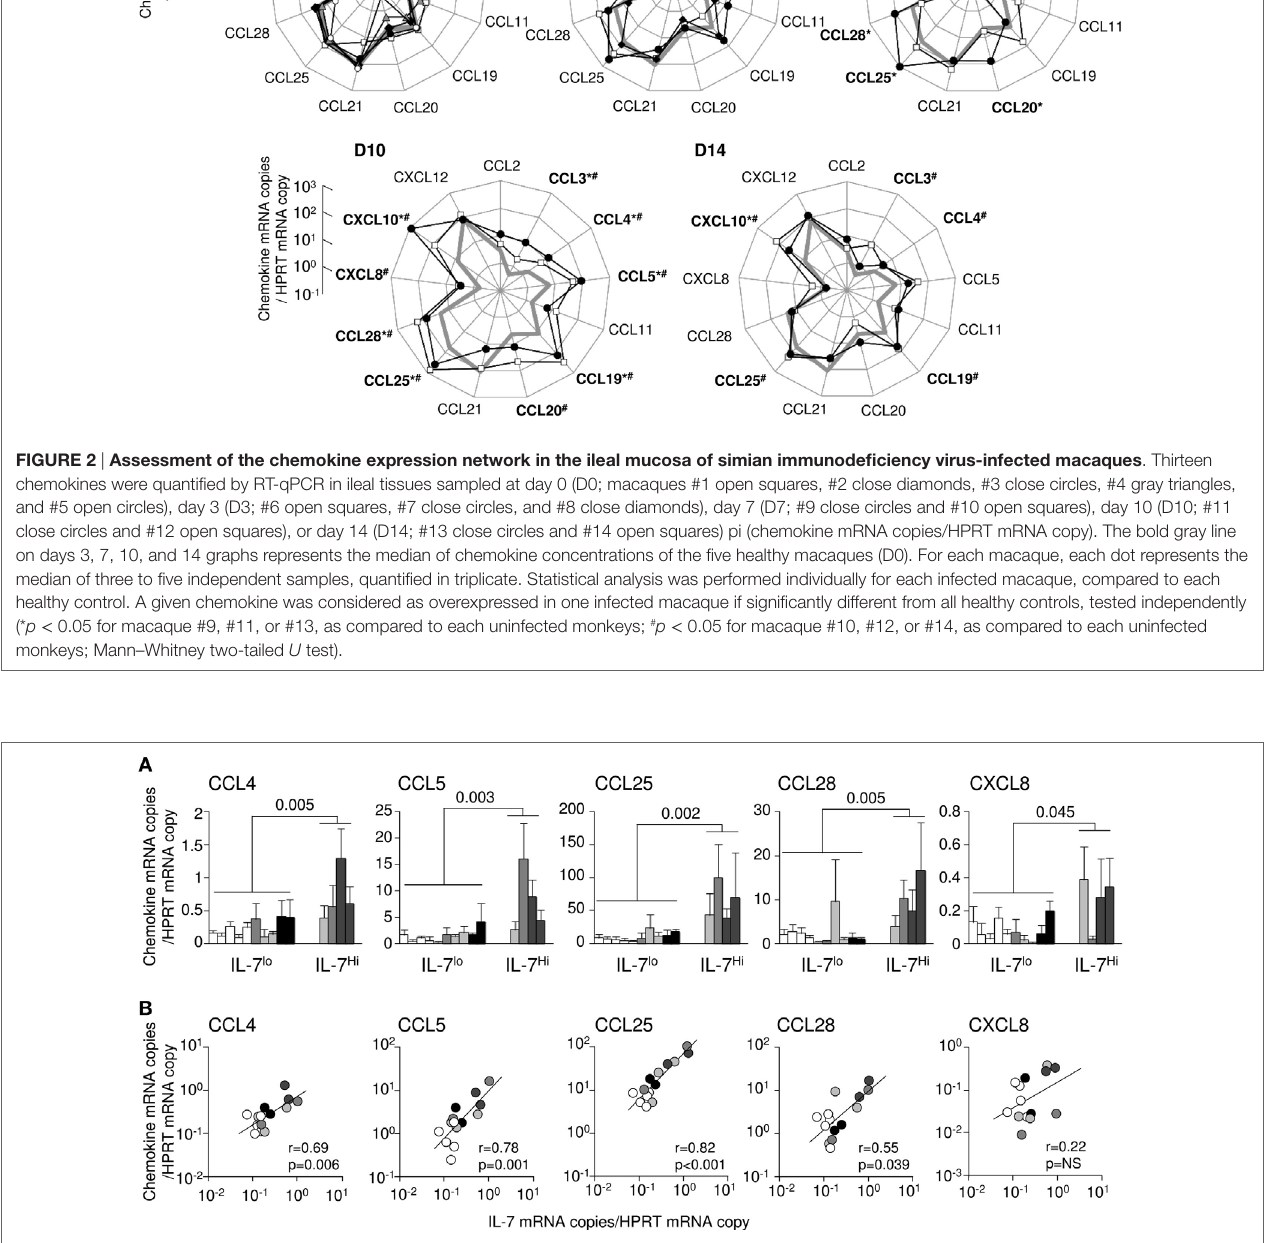
FigUre 3 | interleukin (il)-7 and chemokine expression in the intestinal tract of simian immunodeficiency virus (siV)-infected rhesus macaques . (a) Chemokine expression in acutely SIV-infected macaques presenting high (macaques #7, #9, #11, and #12; IL-7 Hi ), or low (uninfected macaques #1, #2, #3, #4, and #5) and infected macaques (#6, #8, #10, #13, and #14; IL-7 Lo ) IL-7 expression in the ileal mucosa. White bars represent uninfected controls; light gray, medium gray, dark gray, and black bars represent infected animals sampled at day 3, 7, 10, and 14, respectively. Bars and error bars represent means and SDs, respectively. (B) Correlations between IL-7 and chemokine mRNA expressions in the ileum of healthy and SIV-infected macaques (3–10 days post-SIV infection). Each point represents one animal. White circles represent uninfected controls; light gray, medium gray, dark gray, and black circles represent infected animals sampled at day 3, 7, 10, and 14, respectively. The regression lines, the Spearman’s rank correlation value, and the associated probability are